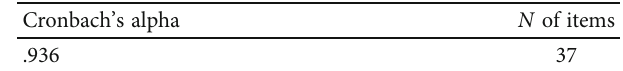
Table 2: Reliability test